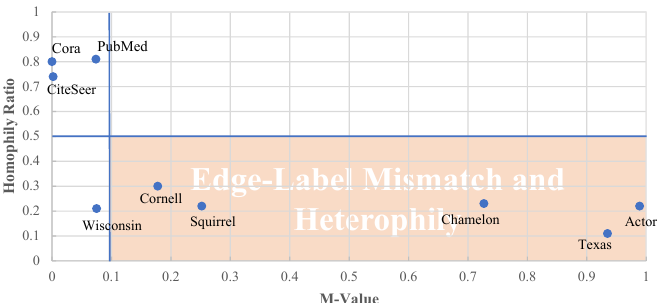
Figure 5. M -value and homophily ratio distribution of benchmark datasets.